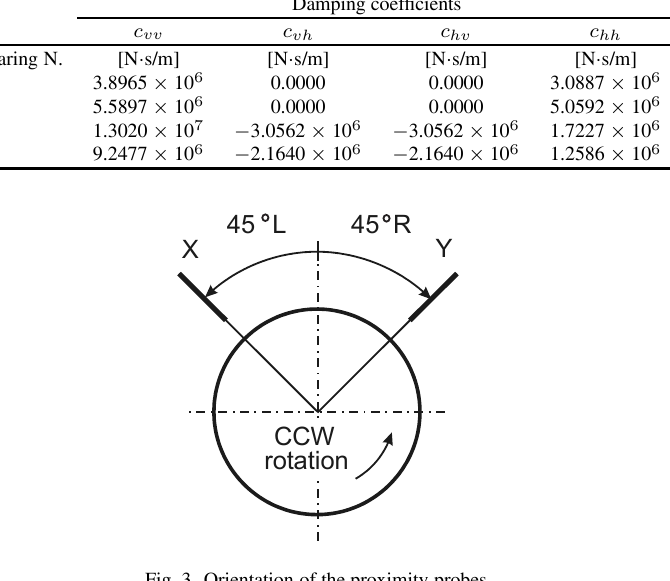
Fig. 3. Orientation of the proximity